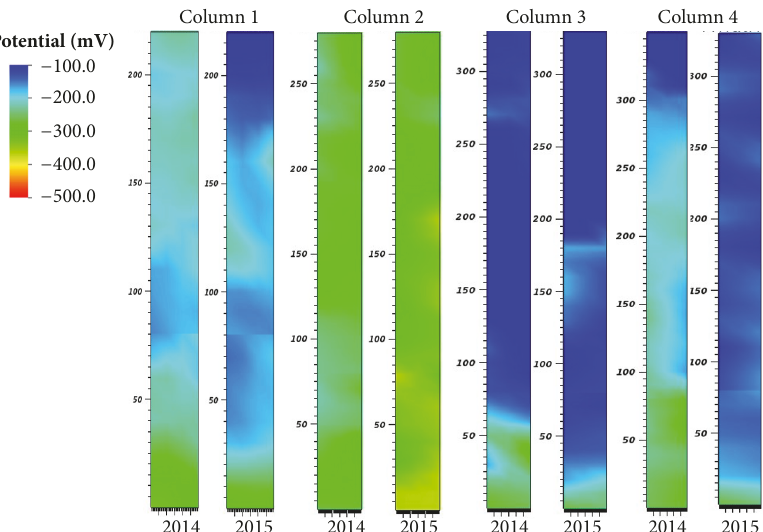
Figure 16: The potential distribution on each column of Object IV for 2014 and